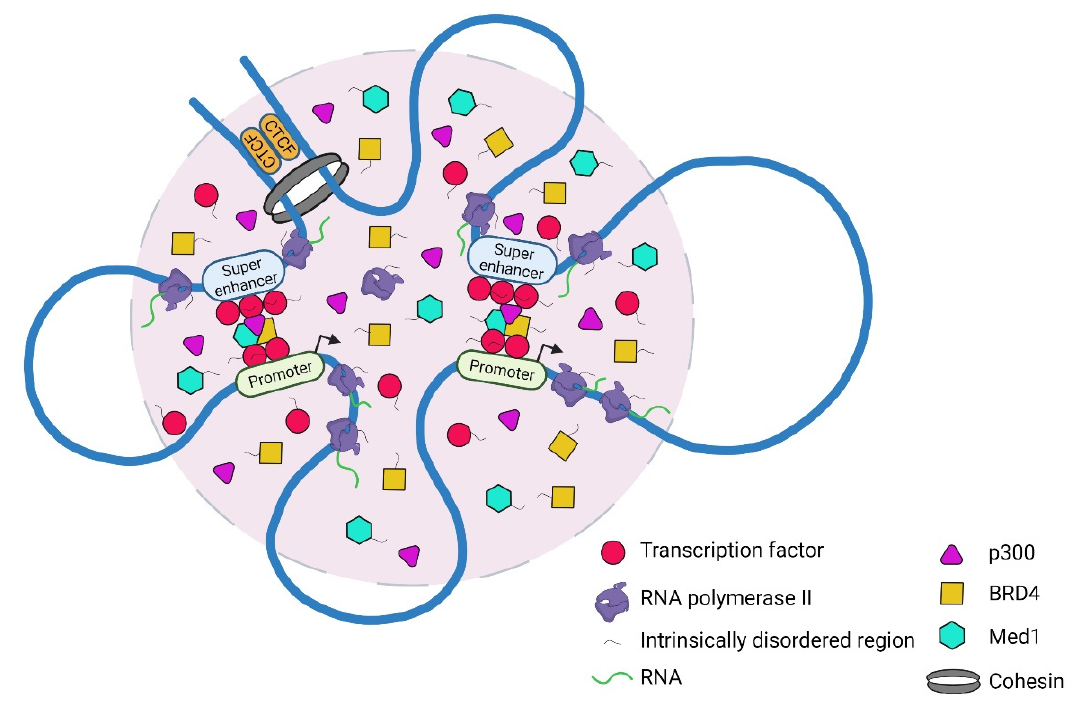
Figure 1. Accumulation of a high density of transcription factors, co-activators (BRD4, MED1, and p300), and RNA polymerase II at super-enhancers drives the formation of transcriptional condensates via phase separation. Transcriptional condensate formation is a cooperative process, involving a combination of weak multivalent protein–protein interactions and electrostatic protein–RNA interactions.